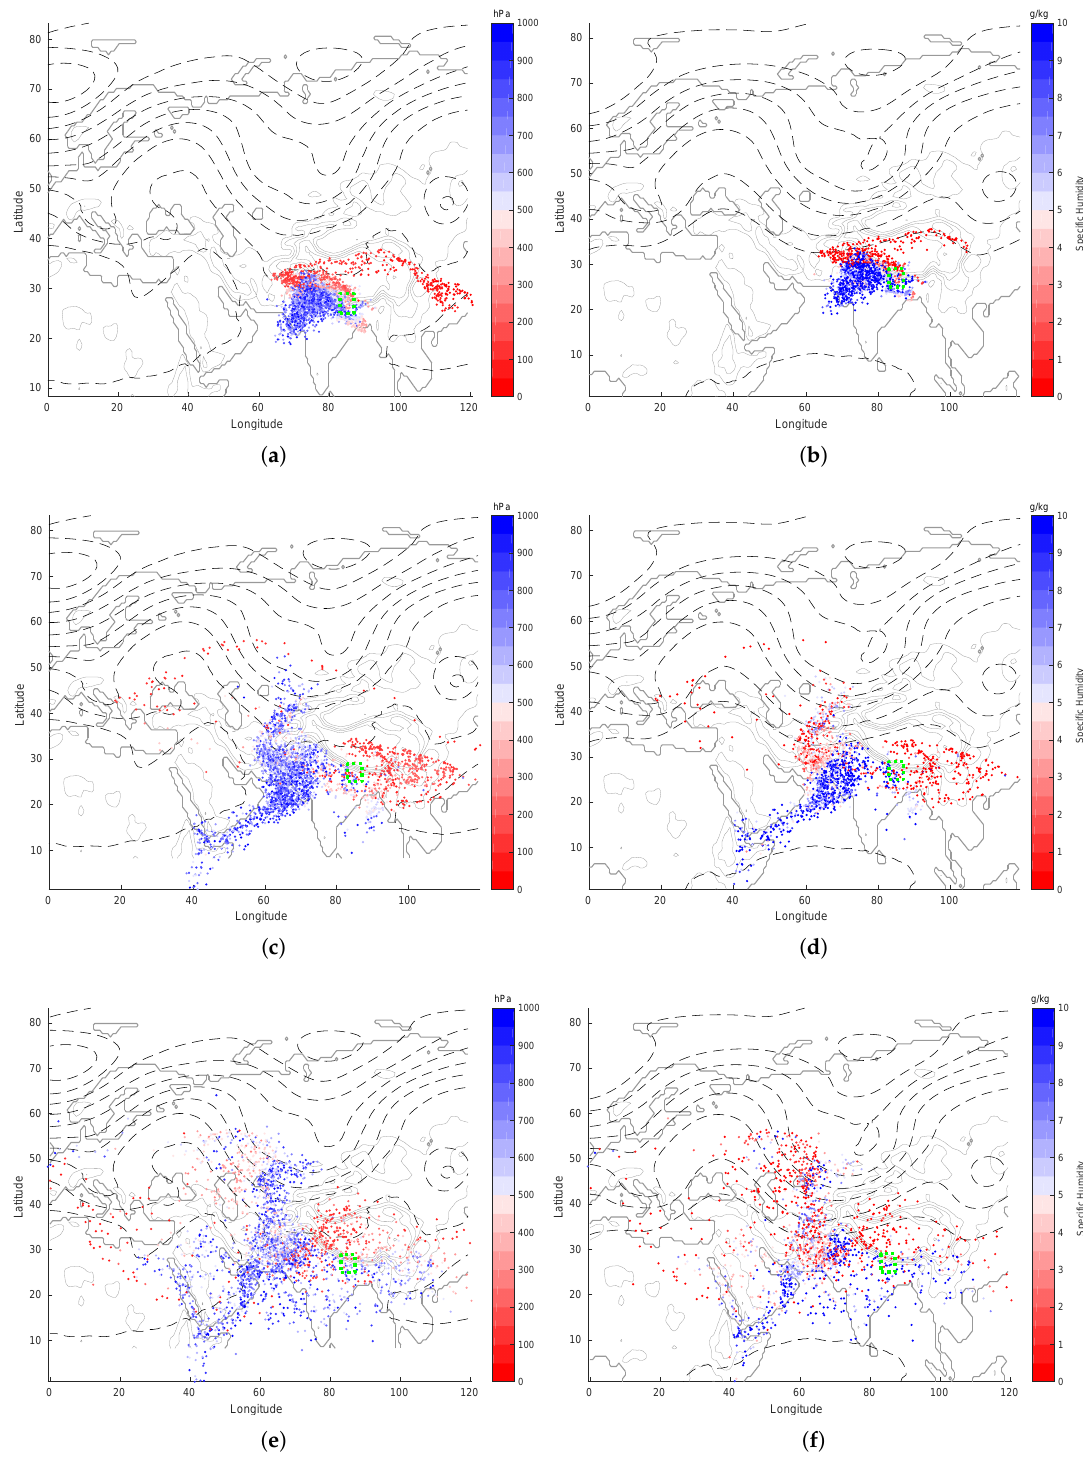
Figure 13. All back-trajectories emanating from K on 13 August 2017. ( a ) parcel pressure, 2 days back in time, along the parcel trajectory; ( b ) parcel pressure, 2 days back in time, along the parcel trajectory; ( c ) parcel pressure, 6 days back in time, along the parcel trajectory; ( d ) specific humidity, 6 days back in time, along the parcel trajectory; ( e ) specific humidity, 10 days back in time, along the parcel trajectory; ( f ) specific humidity, 10 days back in time, along the parcel trajectory. The dashed lines indicate the 5 and 2 day means of 500 mb geopotential height for the left and right columns,